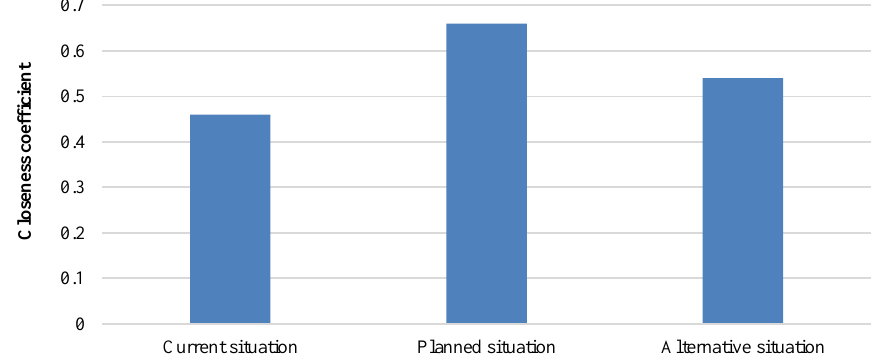
Fig. 3. The coefficients for 3 systems in case